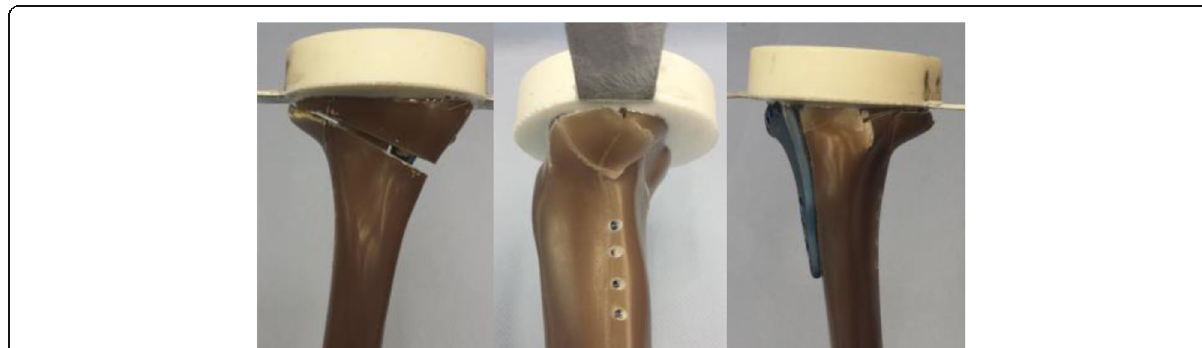
Fig. 5 Fracture of the contralateral cortical bone during the fatigue testing: The specimens failed by fracture of the contralateral cortical bone, similar to the static tests